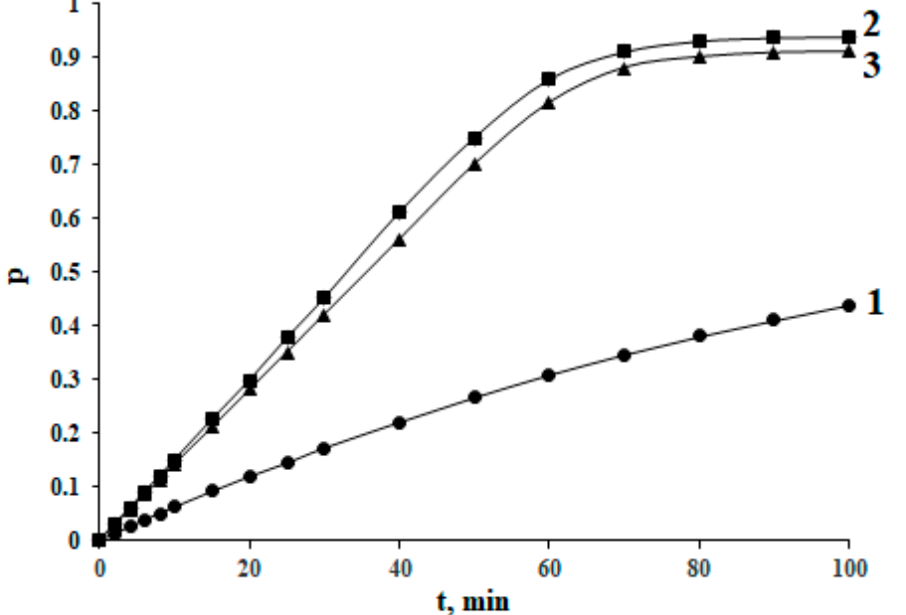
Figure 1. Dependences of conversion (p), on time (t), under conditions of block polymerization of N-vinyl-2-pyrrolidone at a temperature of 343 K initiated by AIBN (6.30 × 10 − 2 mol × l − 1 ): 1—in the absence of chain transfer agents; 2—in the presence of 0.47 mol × l − 1 sulfanylethanoic acid; 3—in the presence of 0.47 mol × l − 1 3-sulfanylpropanoic acid. Acceleration of polymerization of N-vinyl-2-pyrrolidone presumably indicates the participation of mercapto acids in the act of initiation of the reaction, which limits the formation of active centers. If sulfanylethanoic acid and 3-sulfanylpropanoic acids partic- ipate in the formation of active centers, then their concentrations should be considered by the kinetic equation of polymerization. It is known that the radical polymerization of N-vinyl-2-pyrrolidone is accompanied by autoacceleration when it is carried out to high conversions of the monomer (gel effect) [27]; however, at low conversions, the order of monomer concentration is close to unity. Thus, the kinetic Equation (3) can be written: